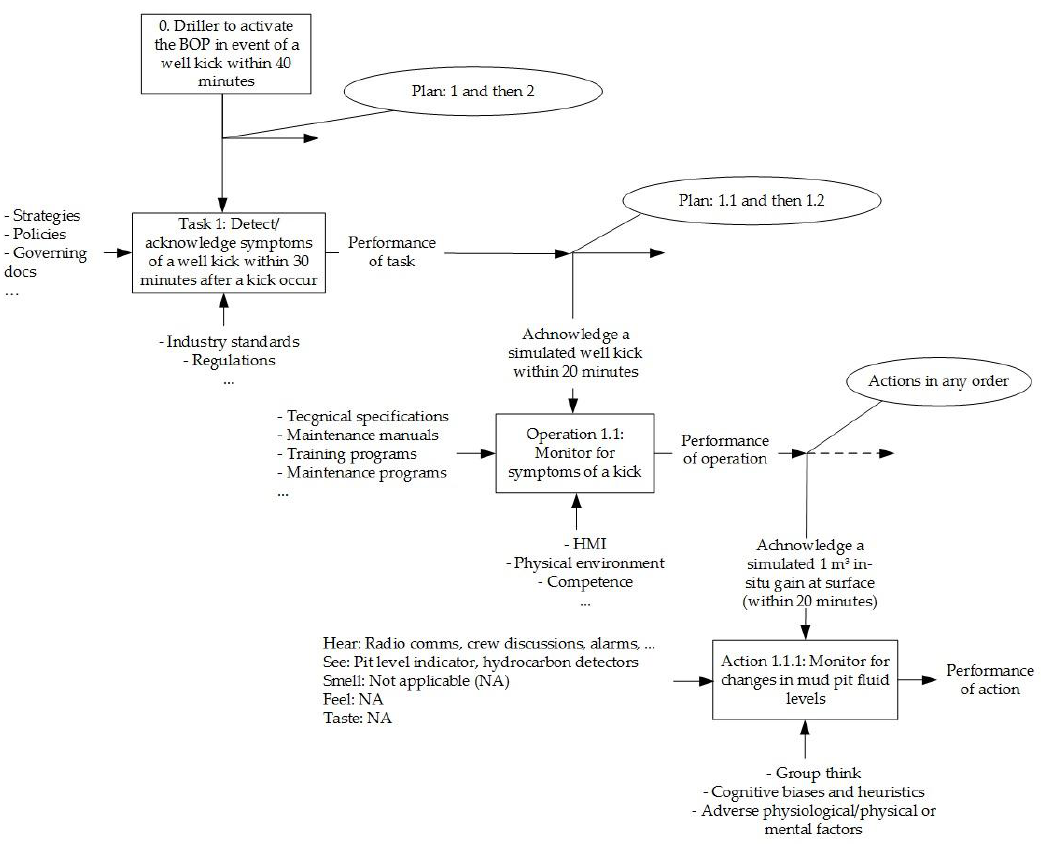
Figure 8. HTA-SADT in task analysis of offshore drilling activity.